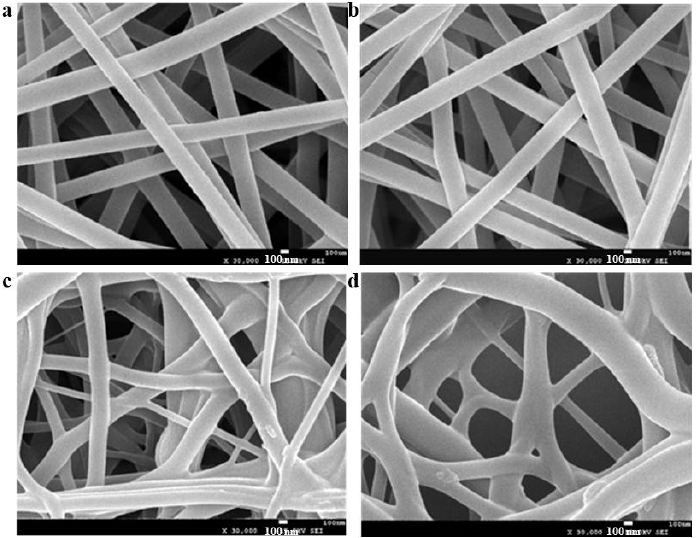
Figure 2. SEM images of nanofiber films: ( a ) PVA; ( b ) nanofiber film PVA / heat treatment (HT); ( c ) nanofiber film PVA / TP-9:1; ( d ) PVA / TP / HT-9:1 nanofiber films.